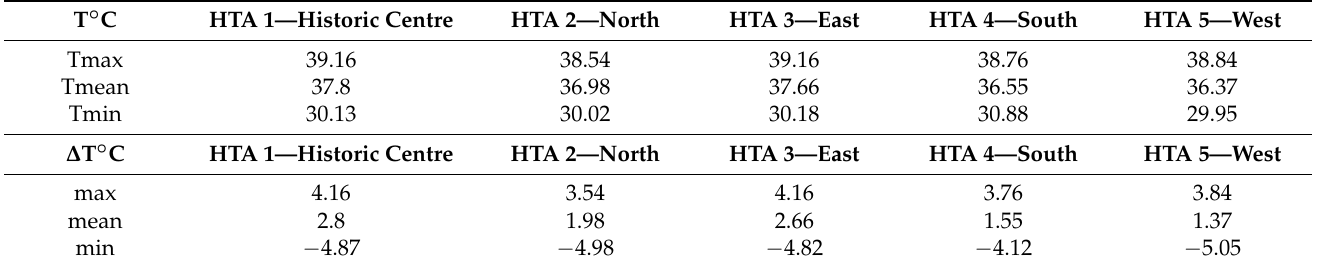
Table 2. Simulated temperatures in the five HTAs and temperature differences compared to the values recorded at the reference weather station at 3 p.m.